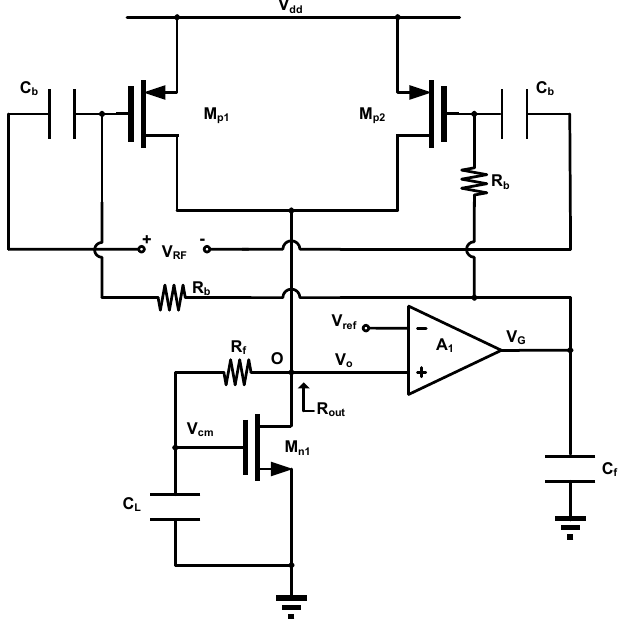
Figure 5. Schematic of proposed envelope